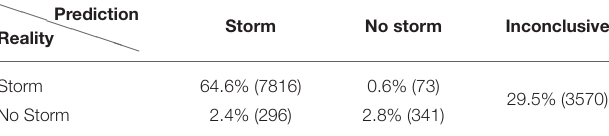
TABLE 6 | FNN 2 using L / I and Az only.